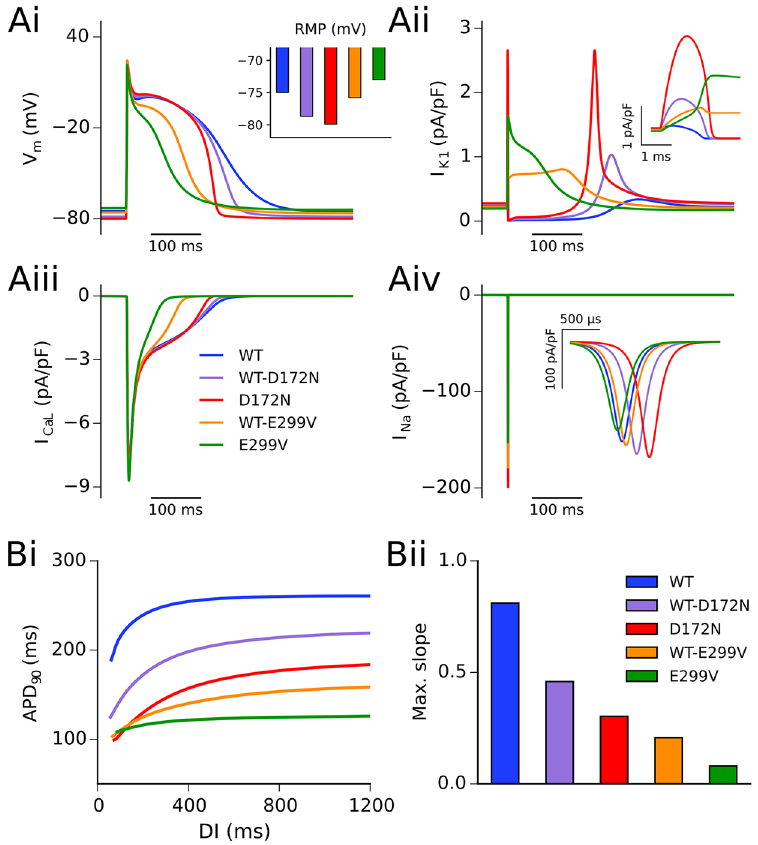
Fig 3. Simulated AP profiles and current tracesin WT and mutation conditions. Action potentialprofiles in WT (blue), WT-D172N (mauve), D172N (red), WT-E299V (orange),and E299V (green)conditionsat a pacingfrequencyof 1 Hz (Ai), with inset showingRMP. Correspondingcurrent traces are shown for I K1 (Aii), I CaL (Aiii), and I Na (Aiv). Insets for panels(Aii) and (Aiv) show current profilesduringthe AP upstroke for I K1 and I Na , respectively.(Bi) Restitutionof the APD 90 as determinedusing an S1-S2 protocol, and (Bii) maximal slope of restitution. https://doi.org/10.1371/journal.pcbi.1005593.g003 E299V mutation conditions, there was almost no difference in APD at the PV/LA junction for the WT-E299V condition, and APs failed to propagate uniformly across the PV region in the E299V condition (conduction blocks shown in black). This was due to the combination of reduced CV and increased electrotonic suppression arising from differences in RMP from the